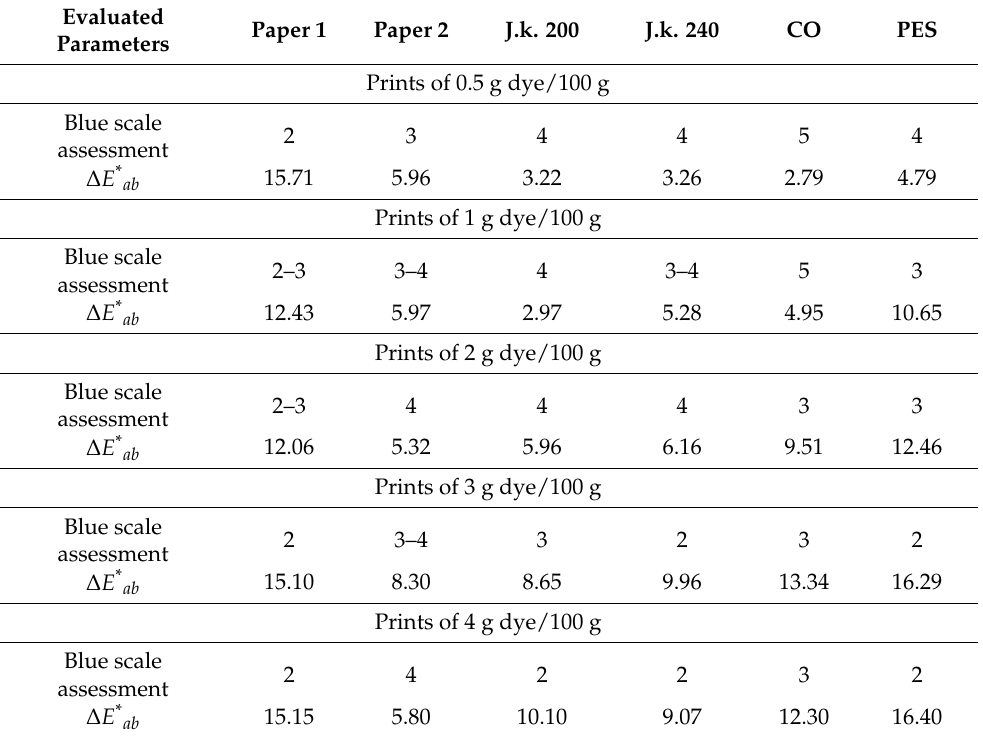
Table 5. Colorfastness of prints to